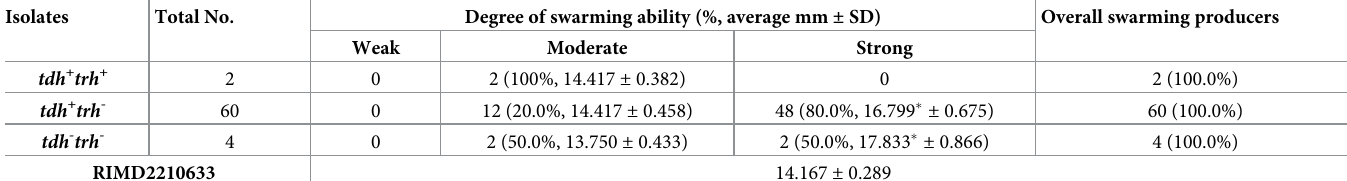
Table 5. Swarming motility of V . parahaemolyticus isolates.